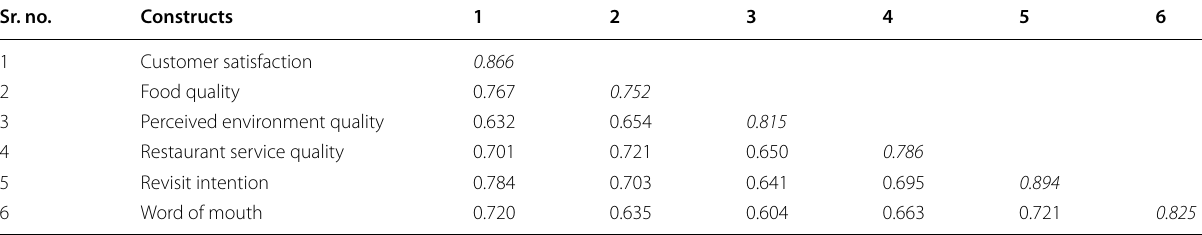
The off-diagonal values are the correlations between latent variables and the italic values are the square root of AVE